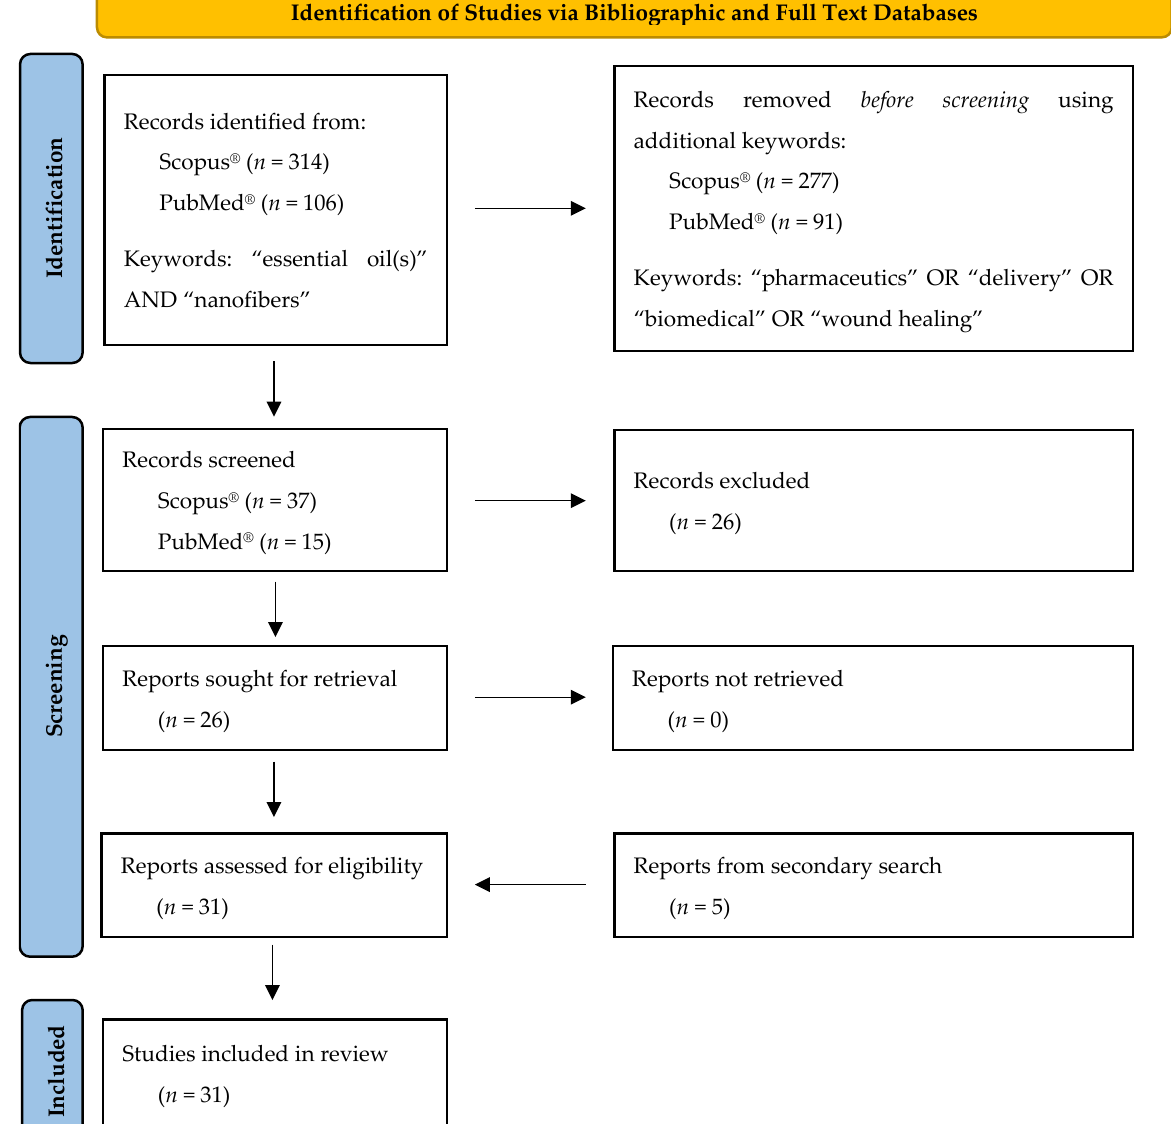
Figure 1. Flow diagram describing the selection, identification and screening methodology of the studies of interest included in the present review according to PRISMA guidelines [25] .